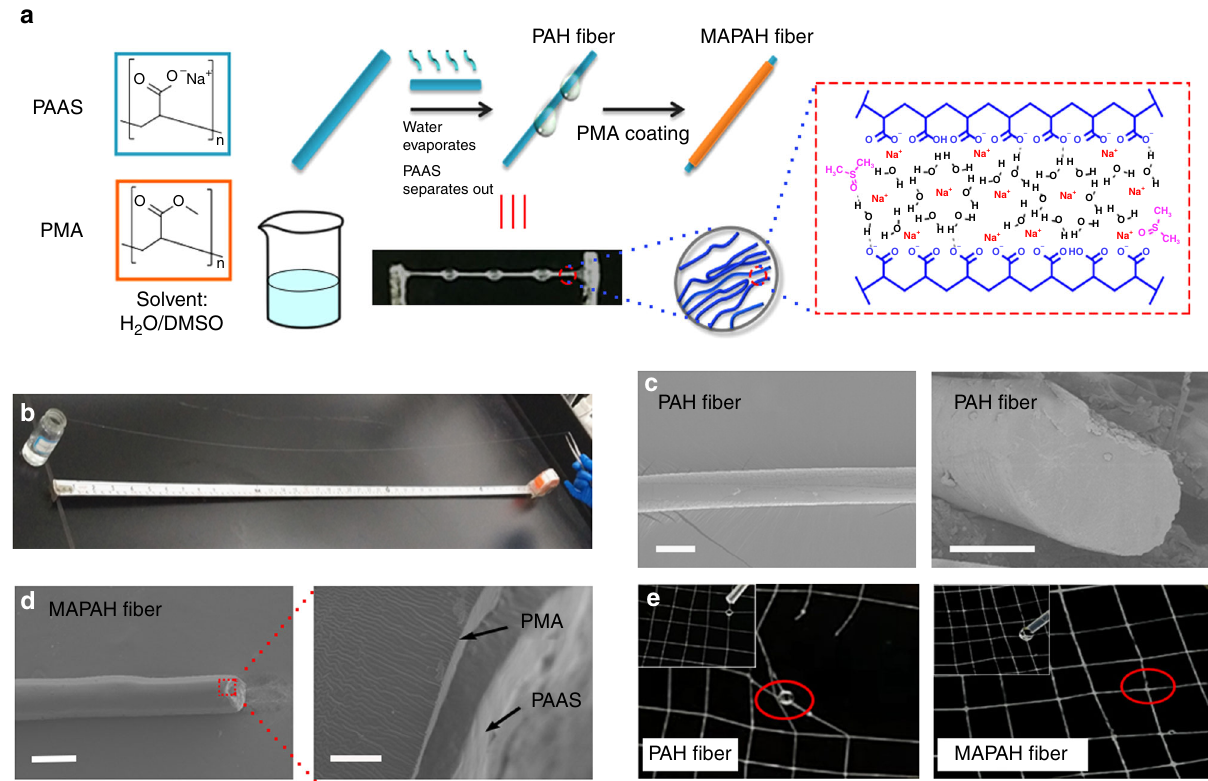
Fig. 1 Preparation of PAH and MAPAH fi bers. a Schematic illustration of the preparation of PAH and MAPAH fi bers. A photograph of as-prepared PAH fi ber shows the beads-on-a-string structure. b Photograph of a 1.1 m-long as-prepared PAH fi ber. c SEM images of a PAH fi ber. The scale bar is 100 μ m. d SEM images of a MAPAH fi ber. The scale bar in the left image is 200 μ m, and the scale bar in the right image is 5 μ m. A thin PMA layer on the PAAS core is clearly observed in the right image. e Photograph of a PAH web damaged by liquid water and a MAPAH web resistant to liquid water. Red circles indicate water droplets remaining on the hydrophilic PAH fi ber, while no water droplet stays on the hydrophobic MAPAH fi